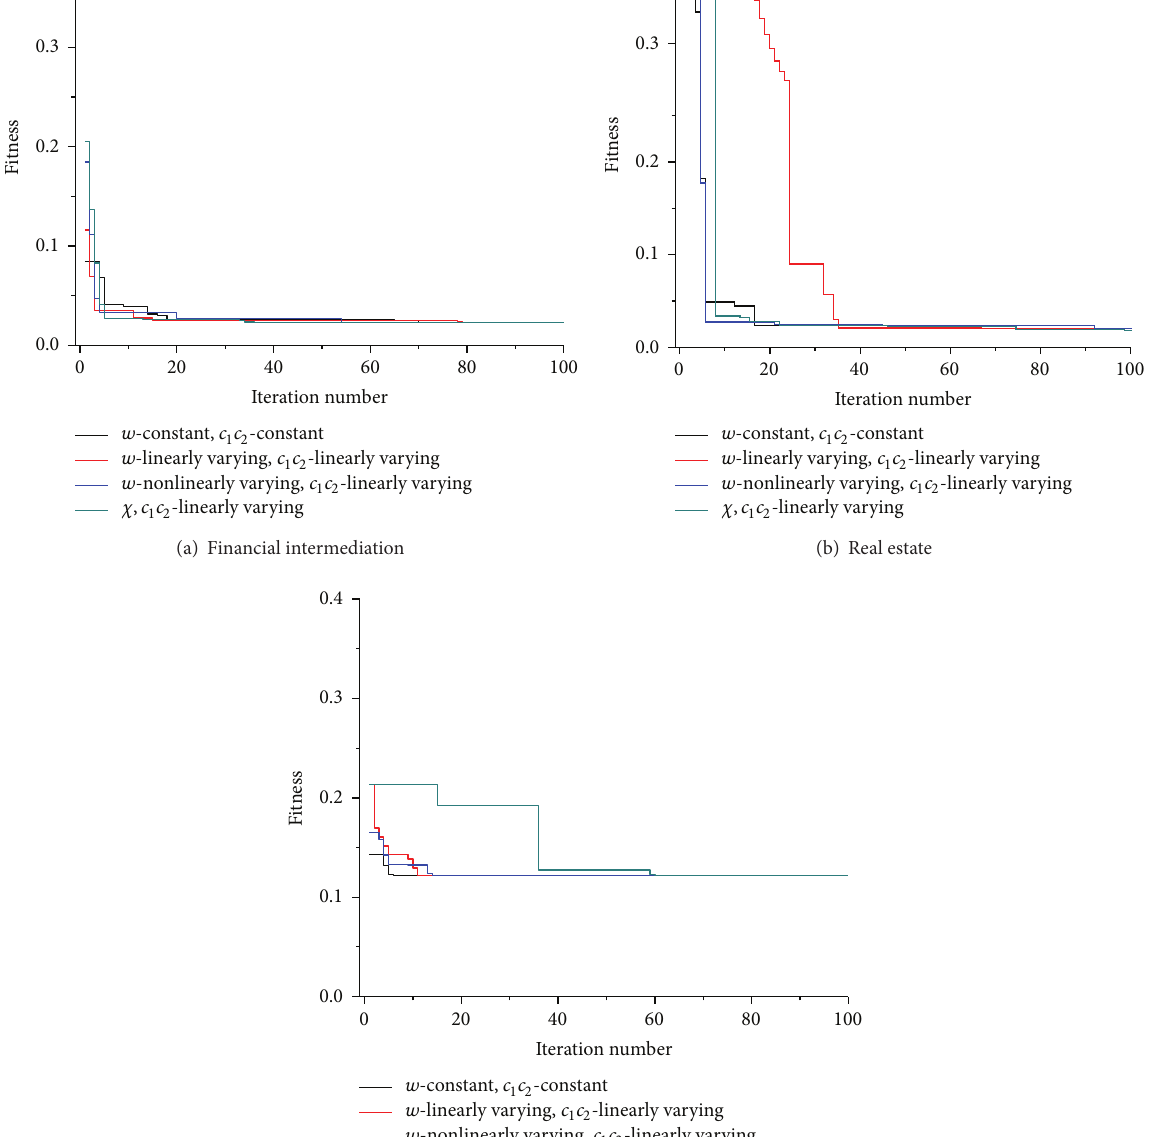
PRGM(1,1) model is almost perfect among three